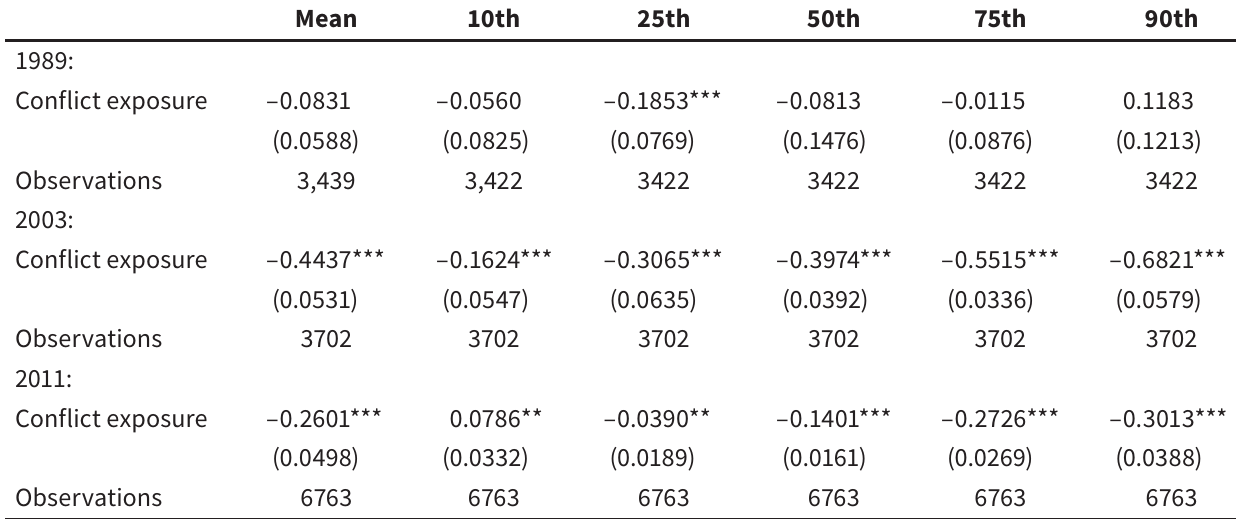
Mean and Quantile Treatment Effects using the Log of Household